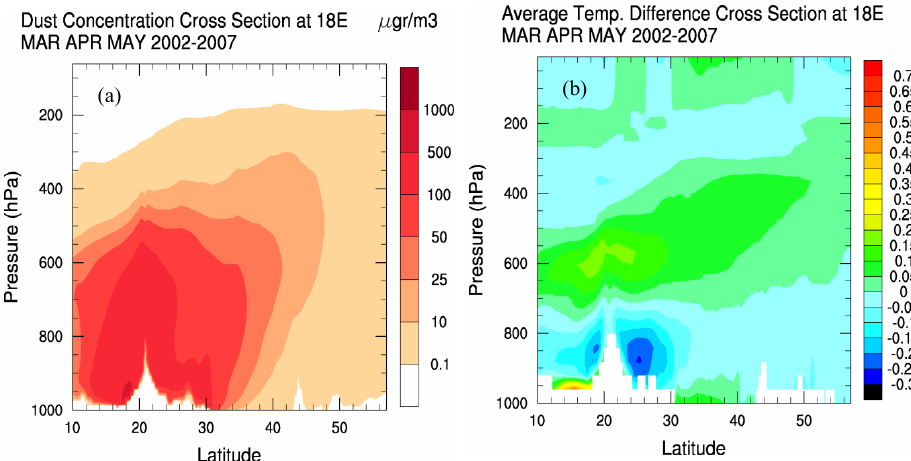
Fig. 15. Vertical cross-sections of (a) dust concentration at 18E and of (b) temperature difference at 18E (WDE – NDE), as averaged for the summer months of the 6-year period from the model simulations before and after incorporating dust–radiation interactions. The white color denotes the